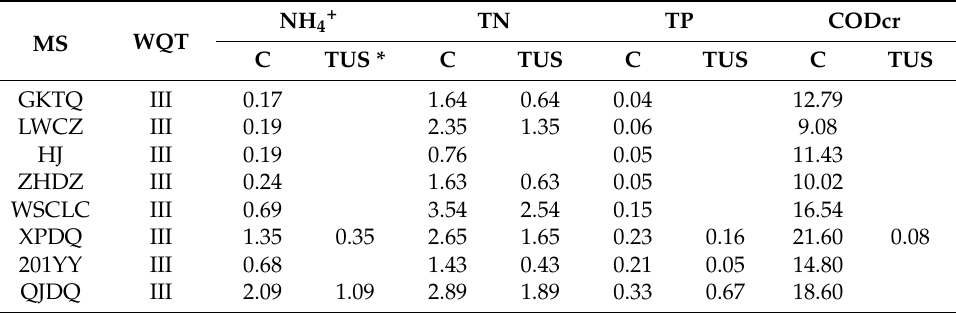
Table 1. The pollutant condition in the monitoring